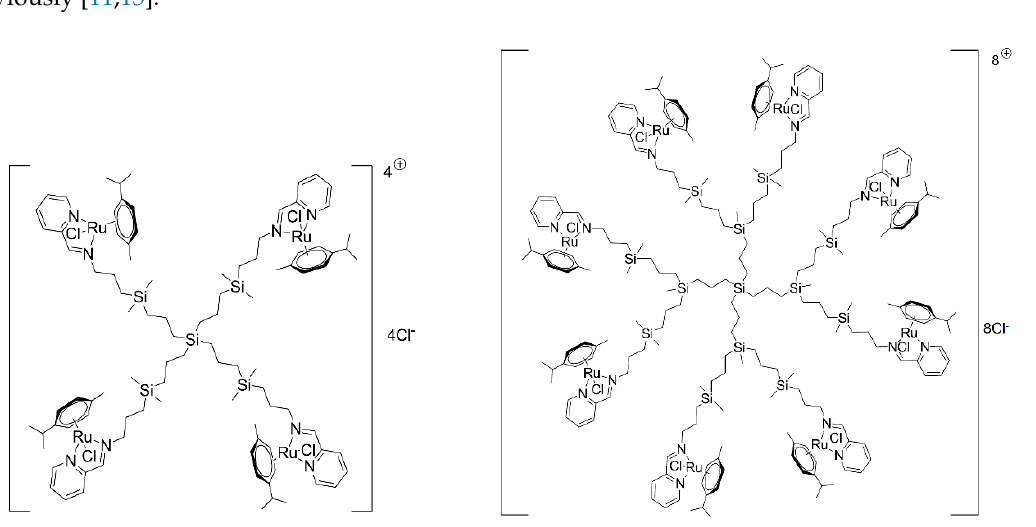
Figure 6. The structure and molecular weight of the 1st (CDR13) and 2nd (CRD27) generations of cationic carbosilane ruthenium (II) dendrimers.